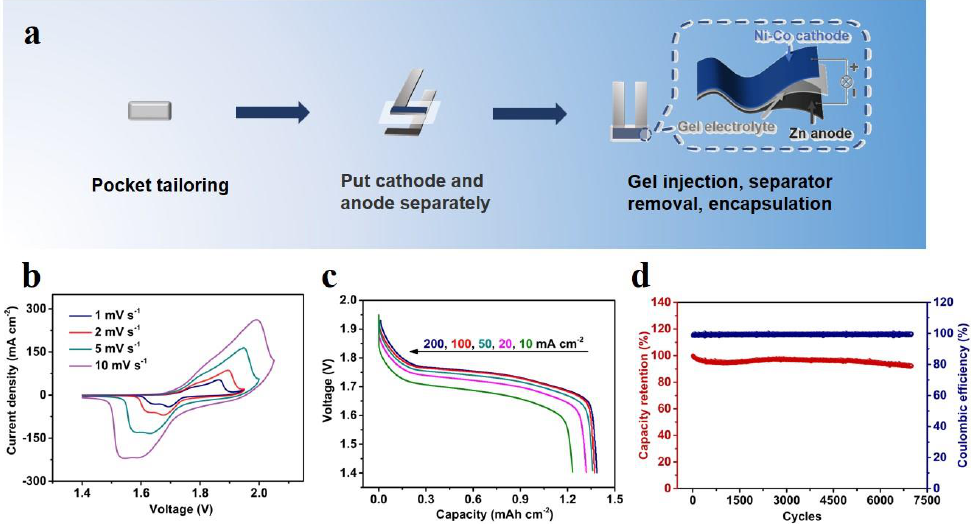
Figure 4. Assembly process and electrochemical performance of the Ni-Zn MB with reconstructed NiCo0.3 microcathode: ( a ) schematic diagram of assembly process, ( b ) CV curves at various scan rates, ( c ) discharge curves under various current densities and ( d ) cycling results.